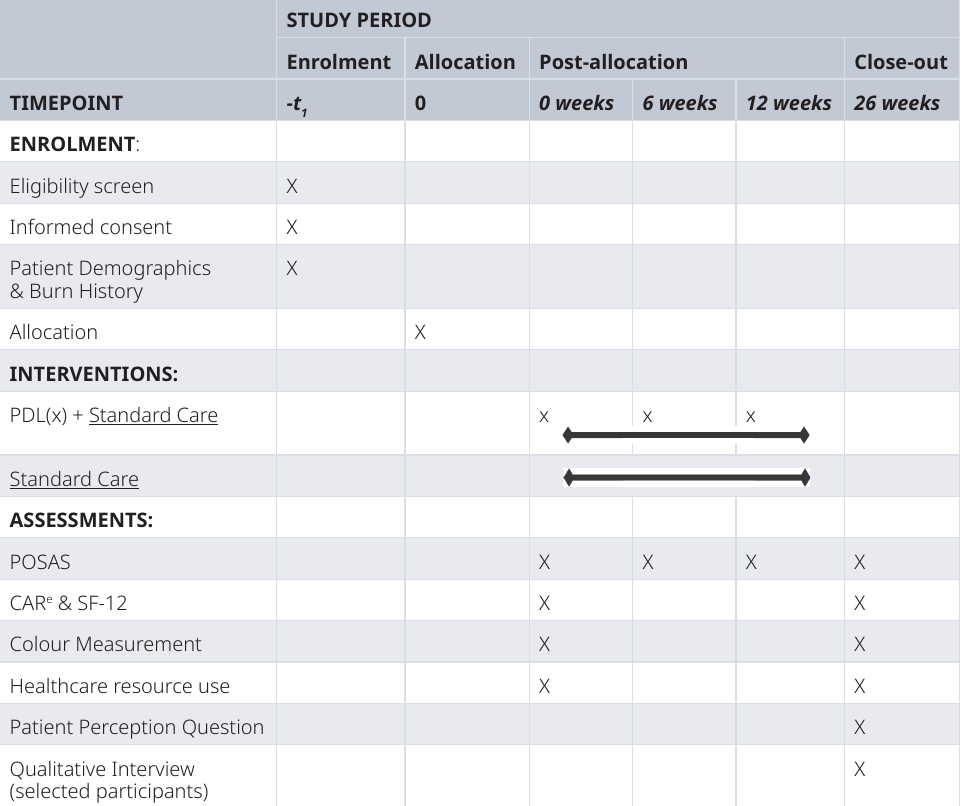
Table 2. Participant timeline over the course of the study. STUDY